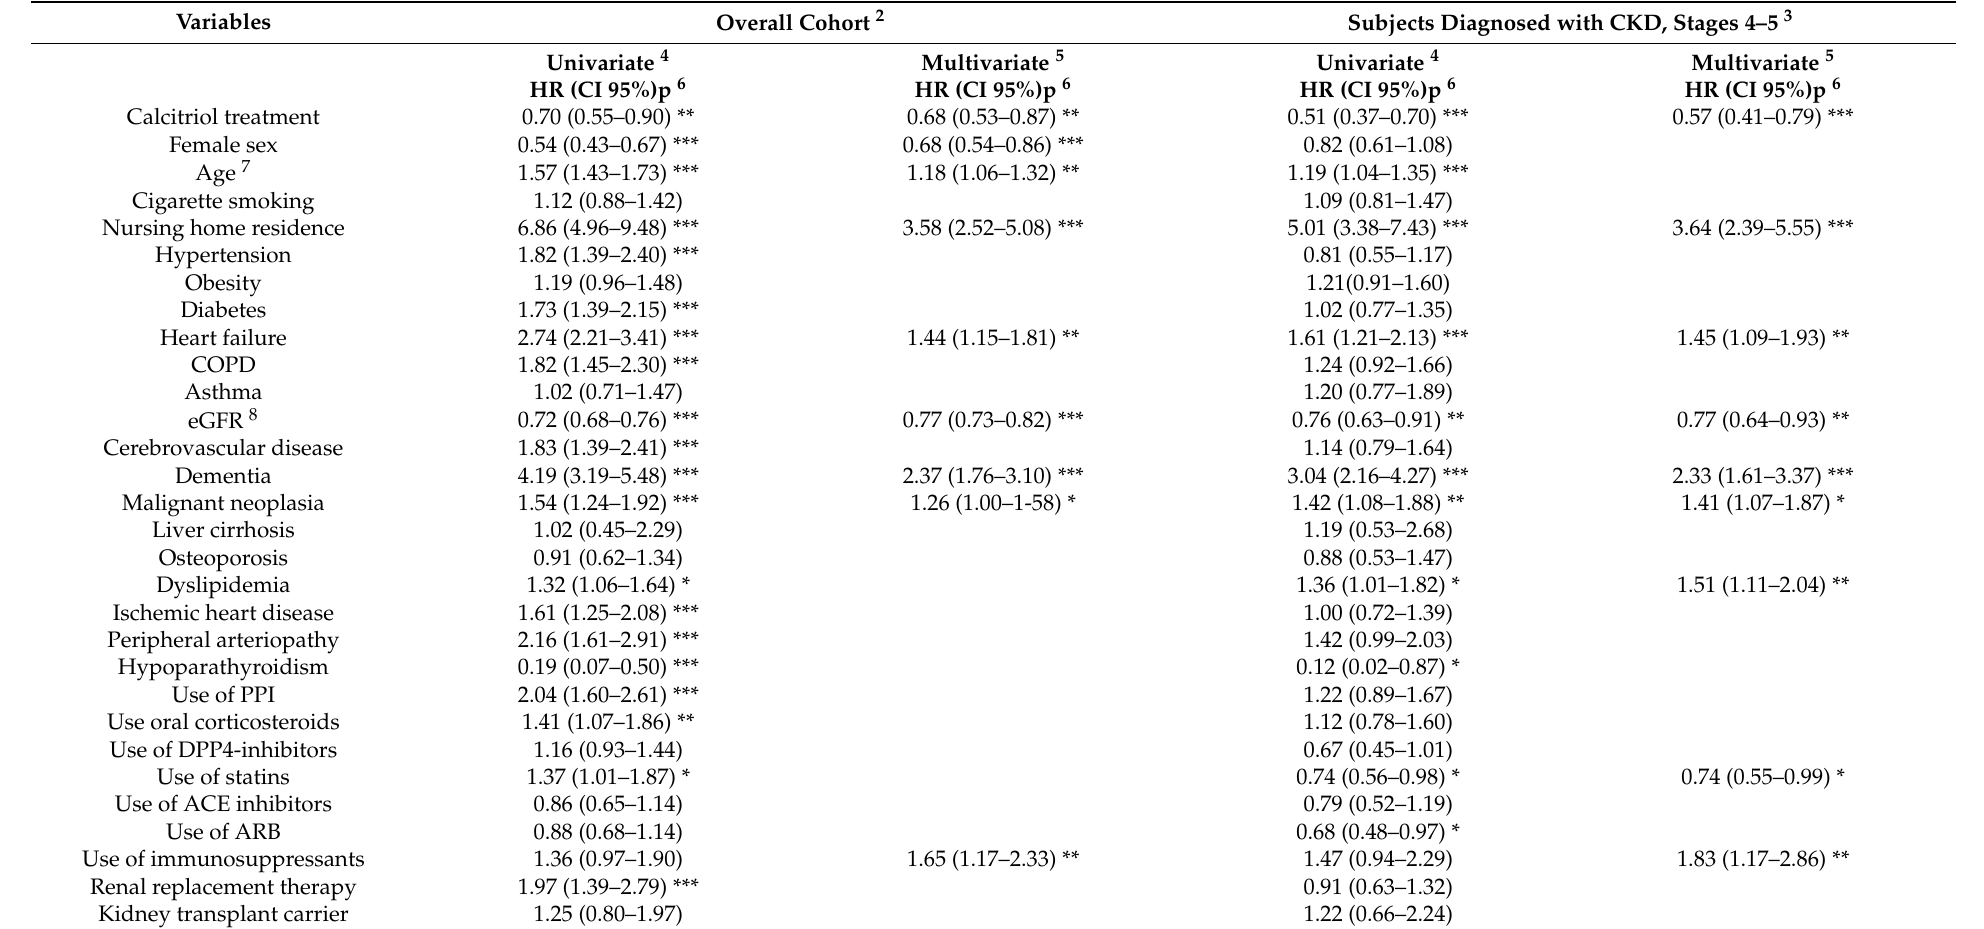
Table 4. Variables associated with severe COVID-19 1 in patients on calcitriol treatment and matched